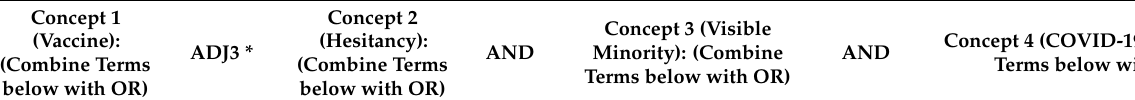
Table 2. Search concepts used in the Medline, PubMed, and CINAHL